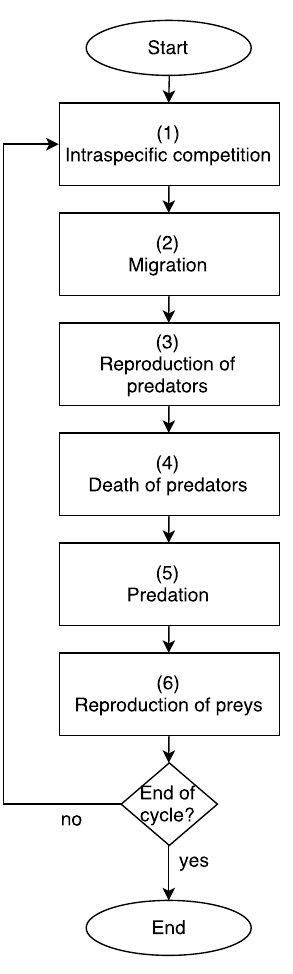
Figure 5. Season—life